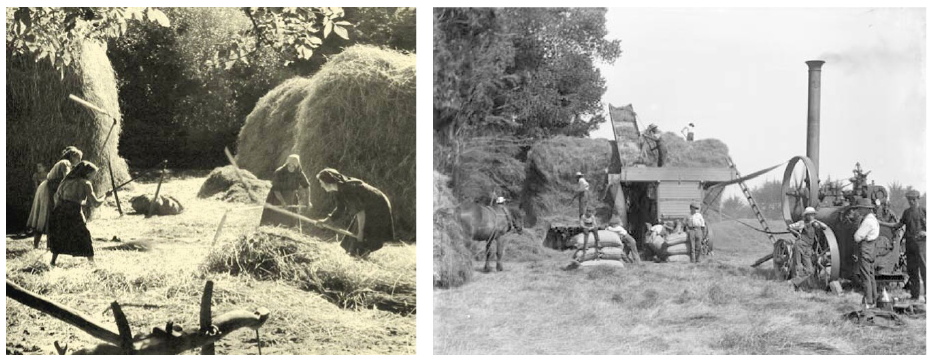
Fig. 4. – Left: threshing via manual labor. Right: threshing by using a threshing machine [16,17].